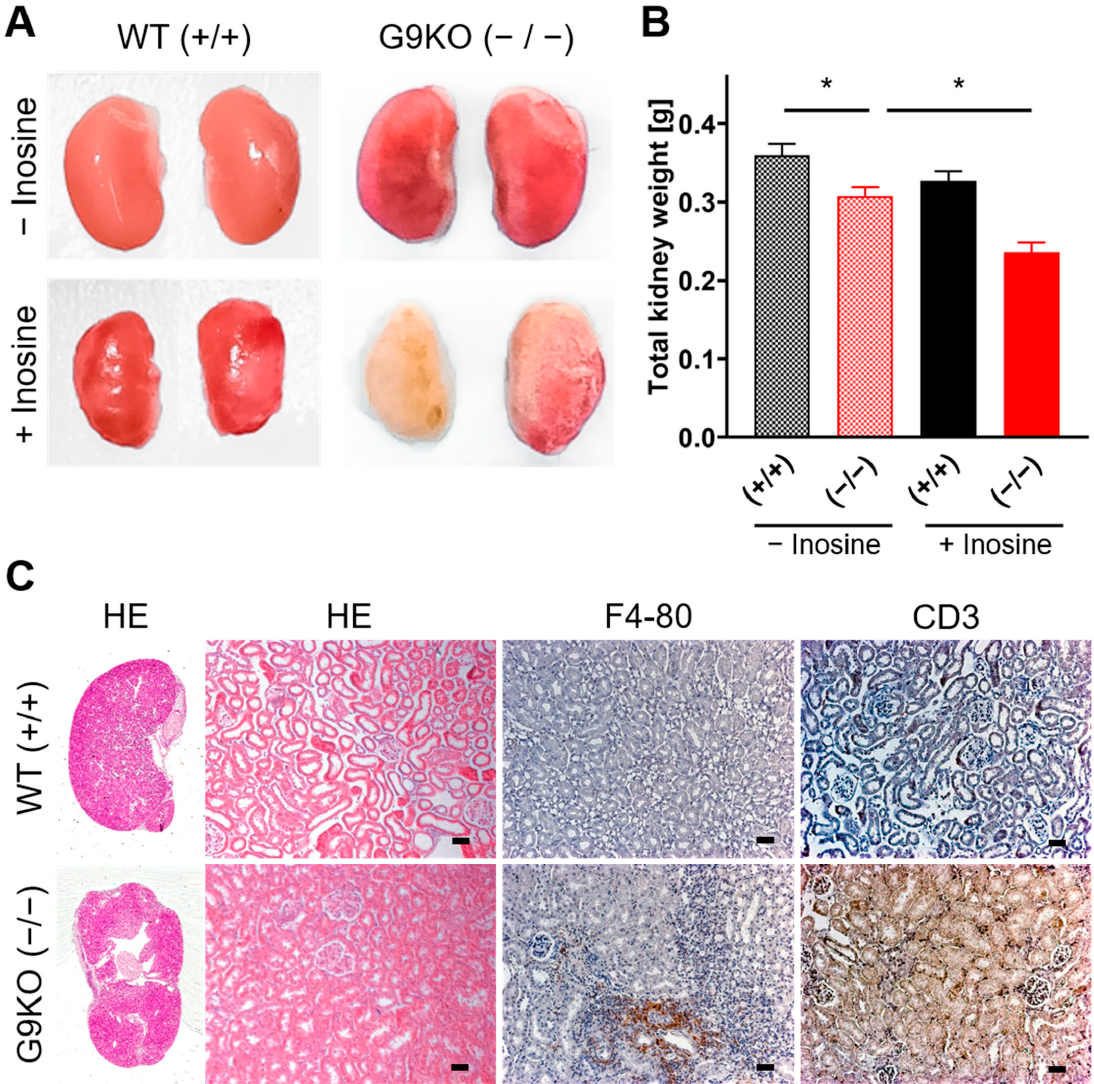
Figure 4. Female kidney status: ( A ) Kidneys isolated at day 70 after birth from WT and G9KO female mice under a control diet and inosine supplementation. Mice show severe morphological changes, which worsen under inosine supplementation. ( B ) Summary of total kidney weight (mean ± SEM) in WT (+/+) and KO ( − / − ) females. Inosine supplementation further reduces kidney weight in G9KO animals. ( C ) HE, F4/80, and CD3 stainings of WT (+/+) and KO ( − / − ) animals exposed to inosine during fetal development. Scale bar: 25 μ m; * p < 0.05. Similarly, homozygous G9KO male kidneys weighed less than those from their WT peers following a diet with or without inosine (Figure 5A): Compared to control males, homozygous KO offspring showed a kidney weight reduction of 18% under the standard chow diet and reduction of 46% under inosine diet (Figure 5B). These kidneys were also characterized by hydronephrosis and by altered histological findings such as tubular at- rophy and interstitial fibrosis in the superficial cortex. Immunohistological staining for